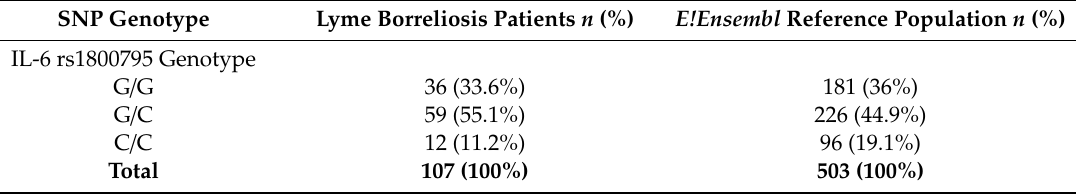
Table 3. Frequencies of IL-6 rs1800795 genotypes in Lyme borreliosis patients compared to a reference